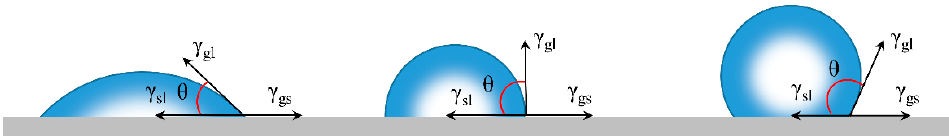
Figure 4. Schematic illustration of Young’s model [73]; the contact angles ( θ ) formed by liquid droplets on a smooth homogeneous solid surface in air (left). A hydrophilic (middle) surface with θ < 90° and a hydrophobic surface with the θ > 90°(right); reproduced with permission from Springer.